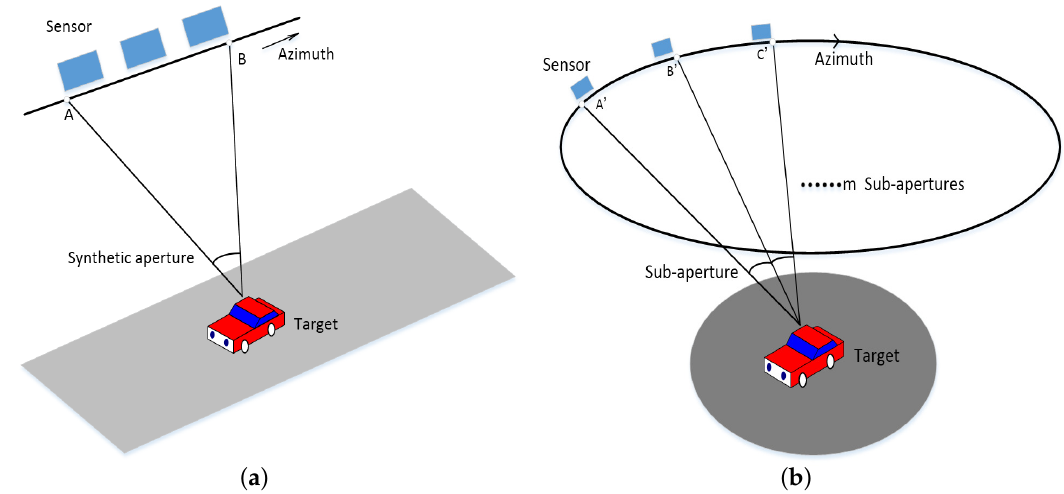
Figure 2. ( a ) Traditional and ( b ) multi-aperture observation